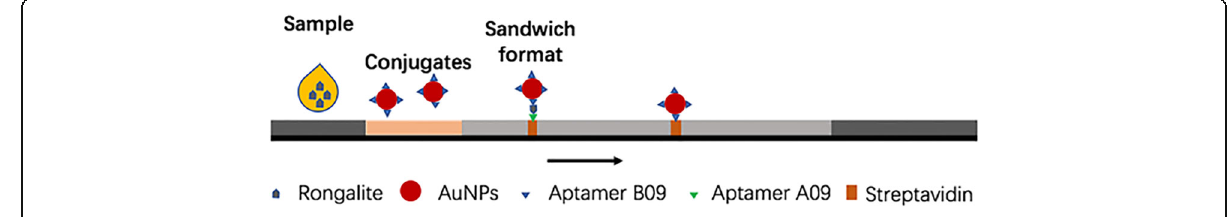
Fig. 3 Typical lateral flow test strip configuration (sandwich format)